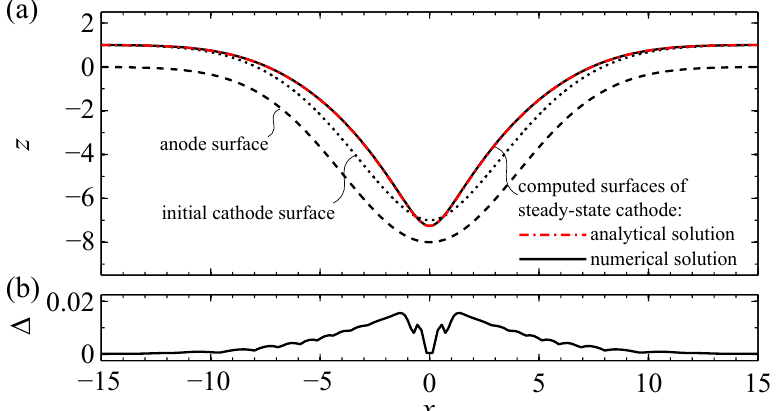
Figure 4. Two-dimensional cathode shape design example. In Panel ( a ), the black dashed line shows the anode shape defined by Equation (17) with A = 8 and σ = 4; the geometry of the cathode at the beginning of the tool design iteration is represented by the dotted black line obtained from equidistantly offsetting the anode geometry by 1; the cathode shape obtained from iterative optimization (solid line) overlaps with the analytical solution (dash-dotted line) obtained from Equations (18) and (19). Panel ( b ) shows the deviation of the numerical result from the analytical solution in surface normal